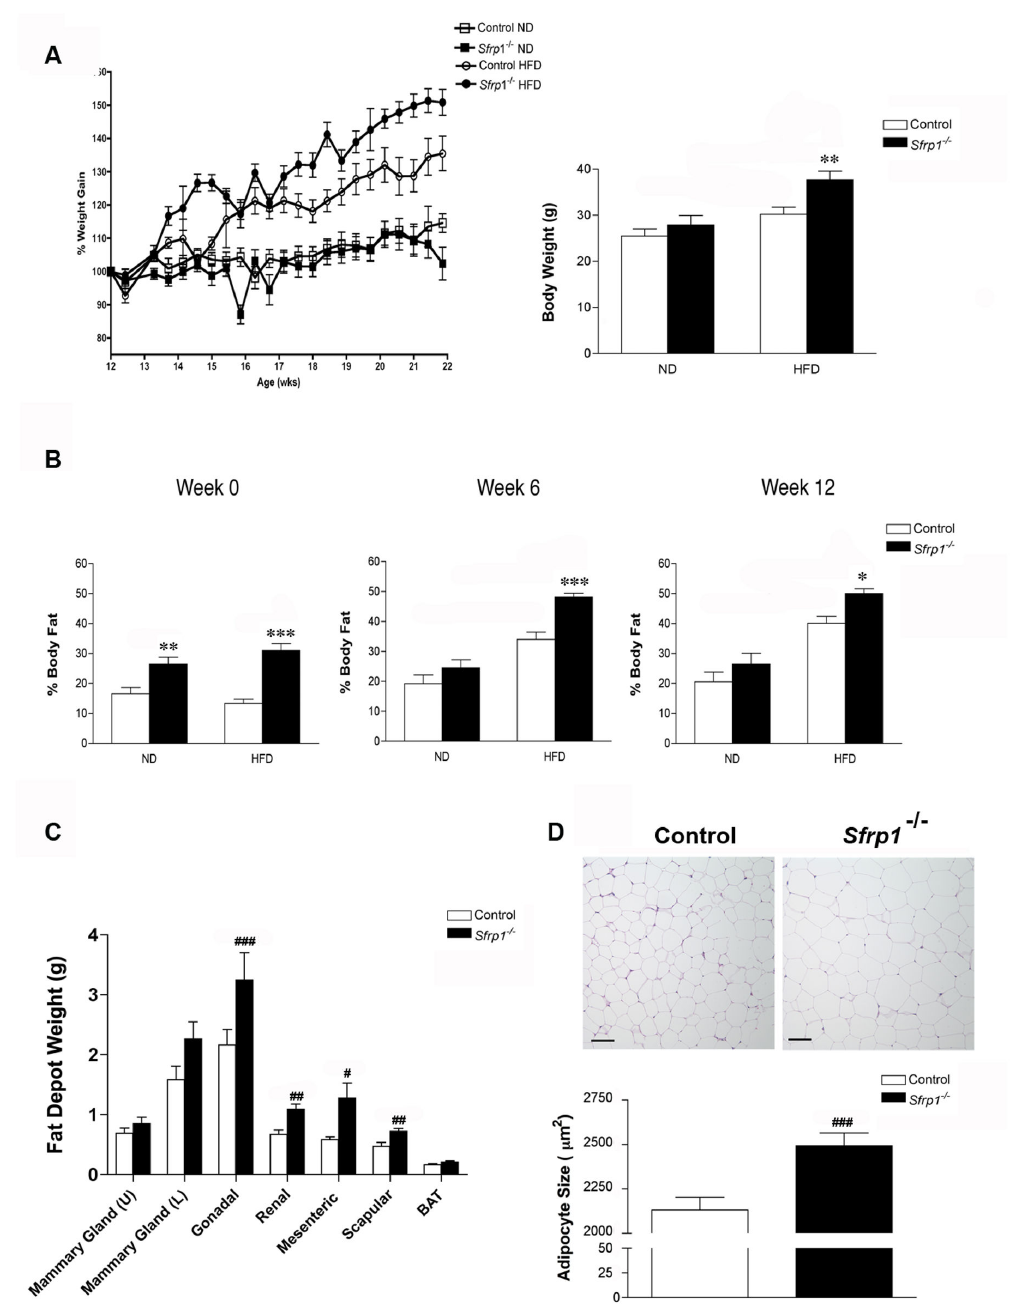
Figure 1. Effects of high-fat diet-induced obesity on weight gain and adiposity. (A) Left panel , The body weight of control and Sfrp1 -/- mice put on a ND and HFD was monitored every 3 days after being put on the diet and changes are displayed graphically as percent initial body weight. Right panel , Final body weight after 12 weeks on the diet. (B) Body composition was analyzed by NMR- MRI at the start of the diet (0 weeks), mid-study (6 weeks), and at the end of the study (12 weeks) and fat mass was normalized to body weight and expressed as percent body fat. (C) Average weight of upper mammary glands (3 rd & 4 th inguinal), lower mammary gland (5 th inguinal), gonadal fat pad, renal fat pad, mesenteric fat pad, scapular fat pad, and brown adipose tissue harvested from mice fed a HFD for 12 weeks. (D) Upper panel , Representative images of H&E staining of gonadal fad pads dissected from mice fed a HFD for 12 weeks. Lower panel , Quantification of gonadal adipocyte size. (*p<0.05,**p<0.01, ***p<0.001 significantly different from control mice fed a ND using Bonferroni’s t test after a two-way ANOVA; # p<0.05, ## p<0.01, ### p<0.001 significantly different from control mice fed a HFD using student’s t test.) . doi: 10.1371/journal.pone.0078320.g001 PLOS ONE |